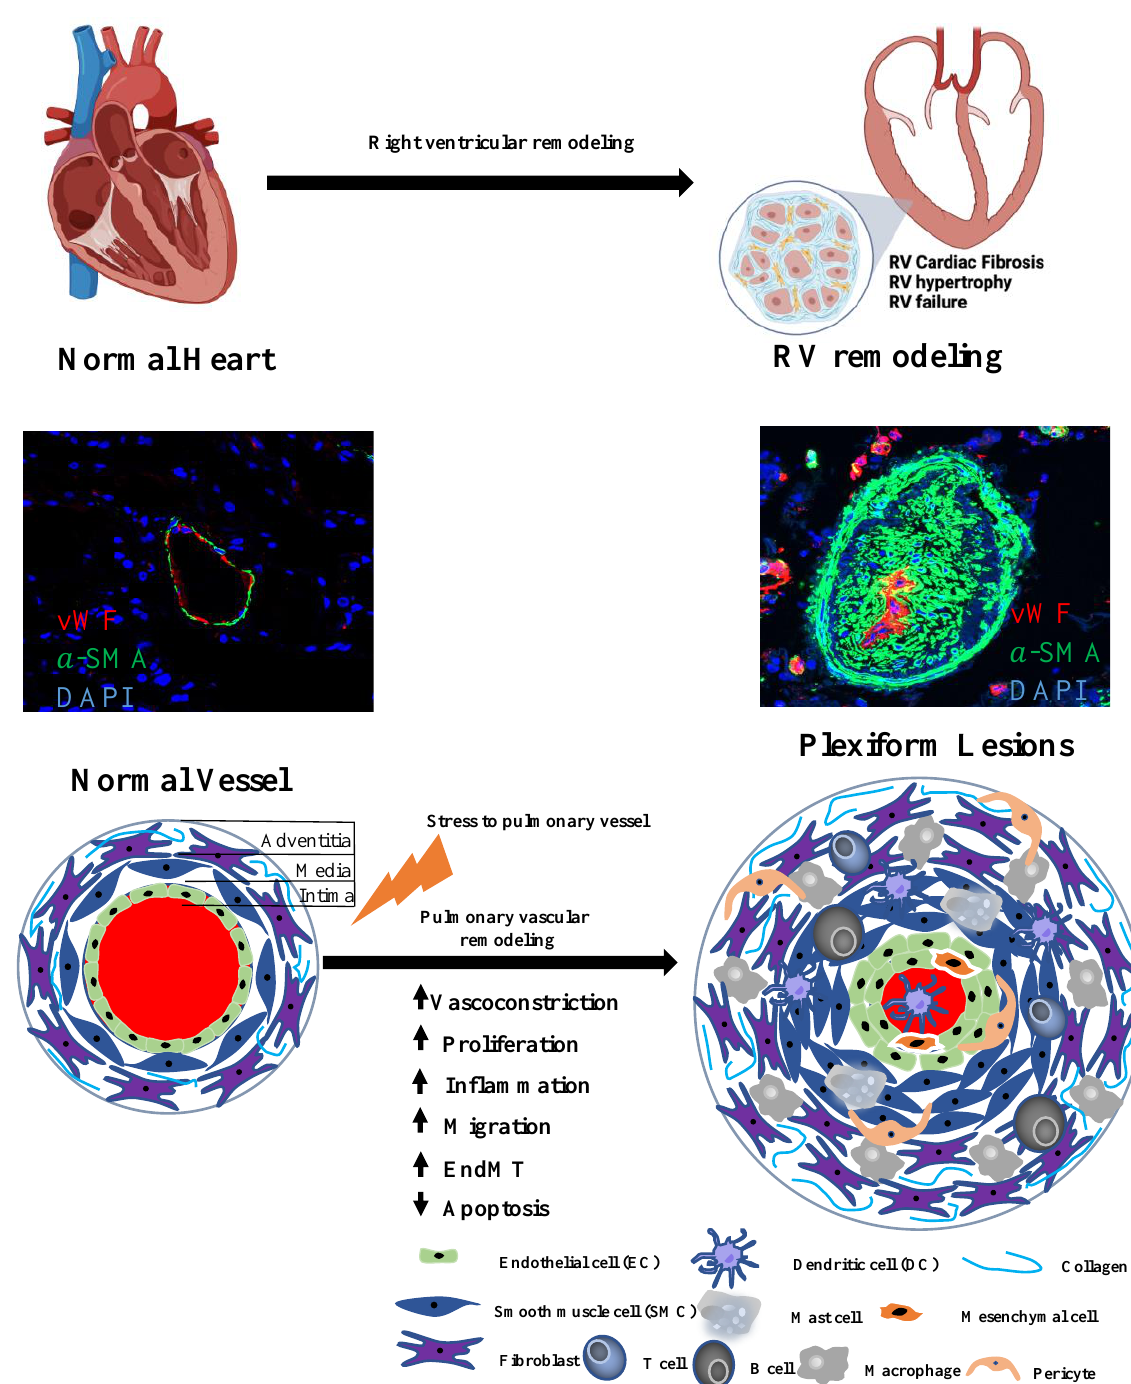
Figure 1. Schematic showing right ventricular and pulmonary vascular remodeling in PH. The right ventricle (RV) undergoes a remodeling process during the development of PH, which includes RV cardiac fibrosis and hypertrophy and eventually right heart failure. The pulmonary artery undergoes changes to all three layers of the vessel, including adventitial thickening with fibroblast proliferation and inflammatory and immune cell recruitment (macrophages, dendritic cells, mast cells, B cells, and T cells), proliferation, resistance to apoptosis and hypertrophy of pulmonary artery smooth muscle and endothelial cell to mesenchymal transition (EndMT), resulting in medial and intimal thickening of the pulmonary vessel wall. vWF:von Willebrand factor, α -SMA: smooth muscle